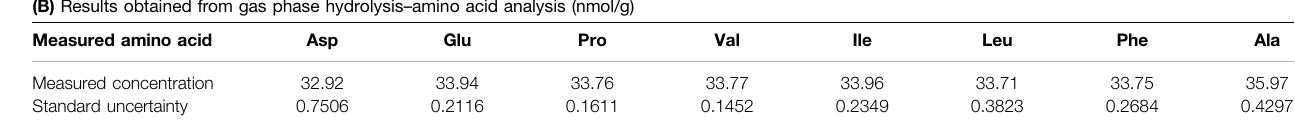
TABLE 3 | Quantitative results of the candidate reference material (RM) by amino acid analyses obtained from liquid phase hydrolysis (A) and gas phase hydrolysis (B) . The detailed uncertainty budgets are summarized in Supplementary Table S7 . (A) Results obtained from liquid phase hydrolysis – amino acid analysis (nmol/g) Measured amino acid Measured